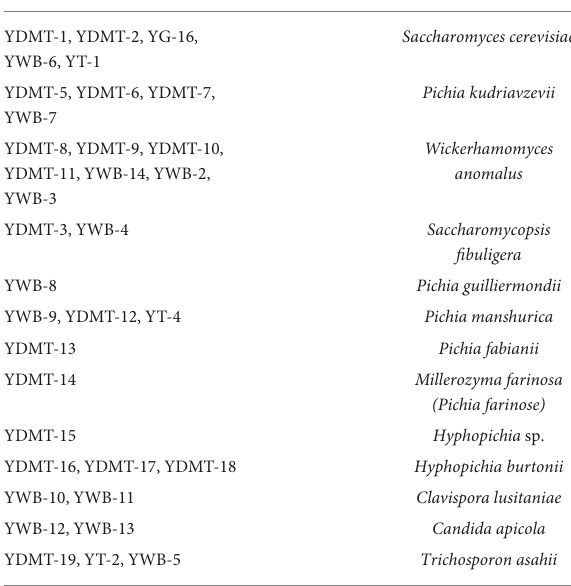
TABLE 1 Identification results of different types of